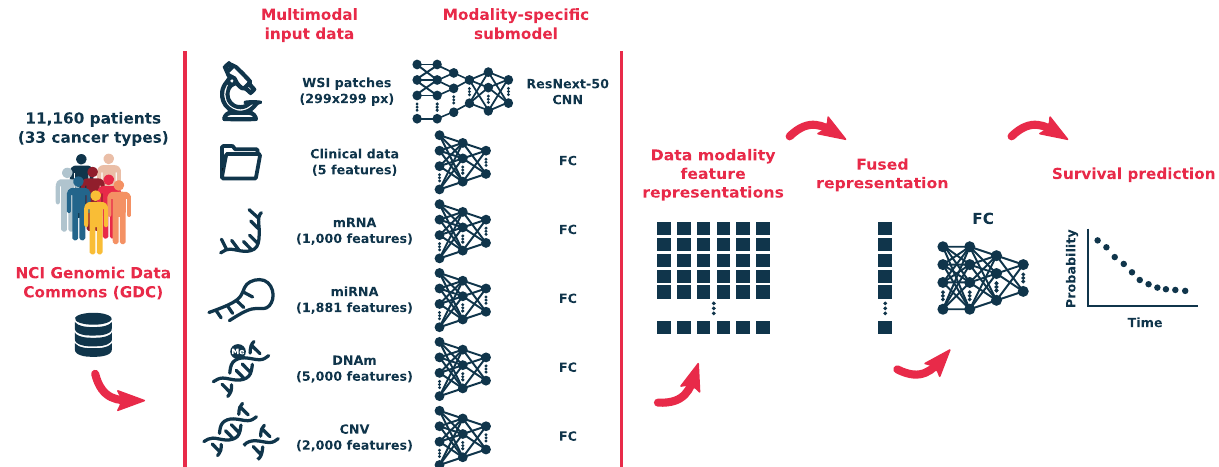
Figure 1. The MultiSurv model architecture. Input data are all from the NCI Genomic Data Commons database, including up to six different data modalities. Each data modality is handled by a dedicated DL submodel, trained to generate modality-specific feature representations. A data fusion layer combines the generated feature representation vectors into a single fused representation. A final neural network takes the fused feature representation and outputs a conditional survival probability for each of a set of pre-defined follow-up time intervals. Taking the cumulative product of the set of conditional survival probabilities produces the predicted survival curve. CNN convolutional neural network, FC fully-connected neural